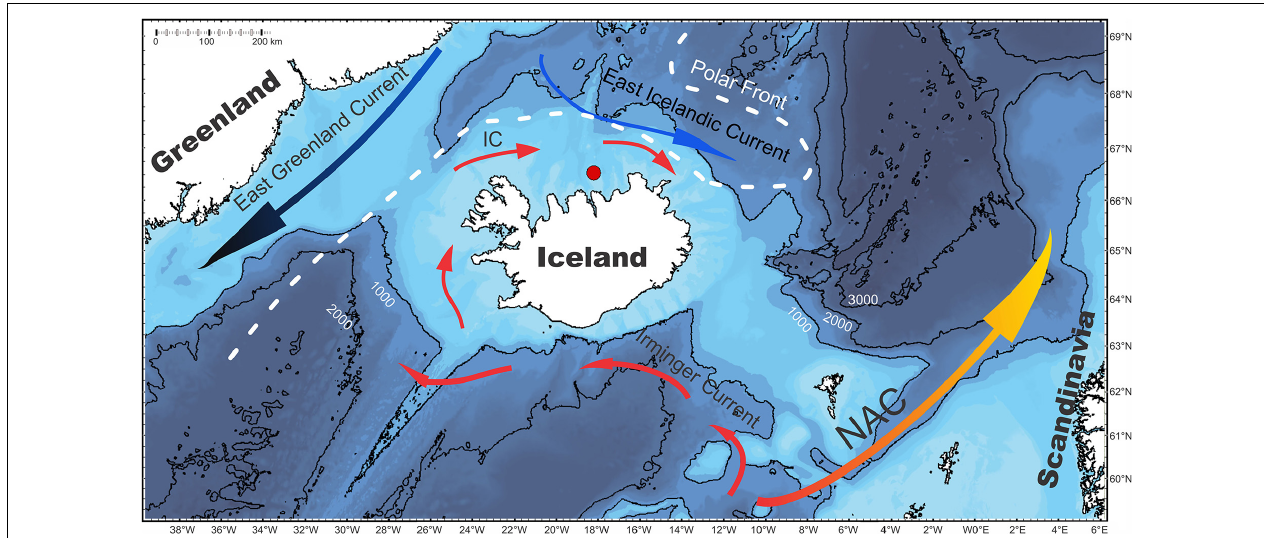
FIGURE 1 | Bathymetric map of the Iceland area. The collection site (red circle) on the North Icelandic Shelf is prone to influences from Irminger Current (IC) and East Icelandic Current (EIC). NAC refers to the North Atlantic Current. Contour lines indicate 1000-m isobaths. The map is adapted after Ran et al. (2011) and Butler et al.